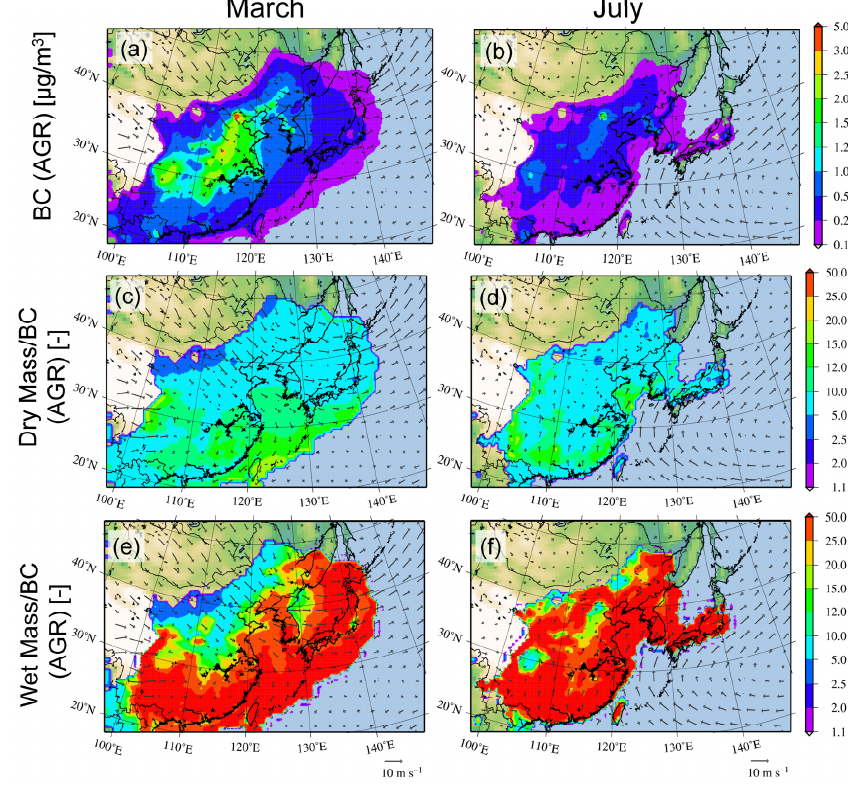
Figure 9. Spatial distributions of mean concentrations and mixing types of black carbon in 2 Fig. 9. Spatial distributions of the mean concentrations and mixing types of black carbon in the lower atmosphere ( < ∼ 1000m) in (left) lower atmosphere (<~1000m) in (left) March and (right) July. (a)-(b) black carbon 3 March and (right) July. (a–b) Black carbon concentration (µmm − 3 ) , (c–d) dry mass to black carbon mass ratio ( − ), and (e–f) wet mass to black carbon mass ratio ( − concentration (µm/m 3 ), (c)-(d) dry mass to black carbon mass ratio (-), (e)-(f) wet mass to 4 black carbon mass ratio (-). 5